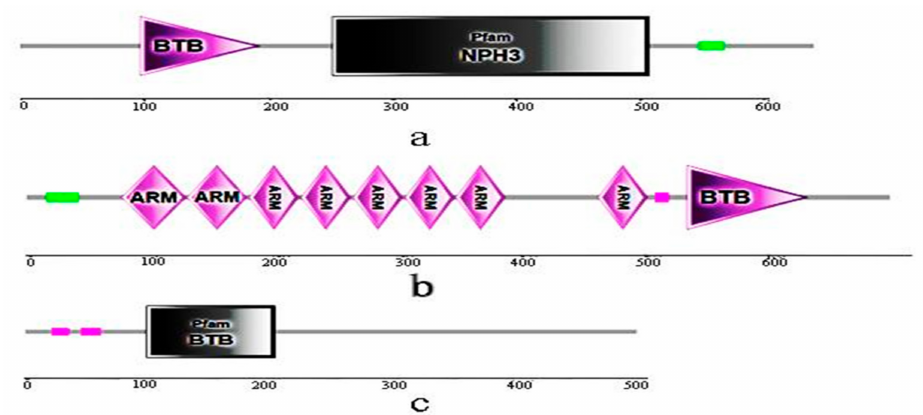
Figure 5. Conserved domains of BvBTB1 , BvBTB2 , and BvBTB3 protein. ( a ) Conserved domain of BvBTB1 protein. ( b ) Conserved domain of BvBTB2 protein. ( c ) Conserved domain of BvBTB3 protein.